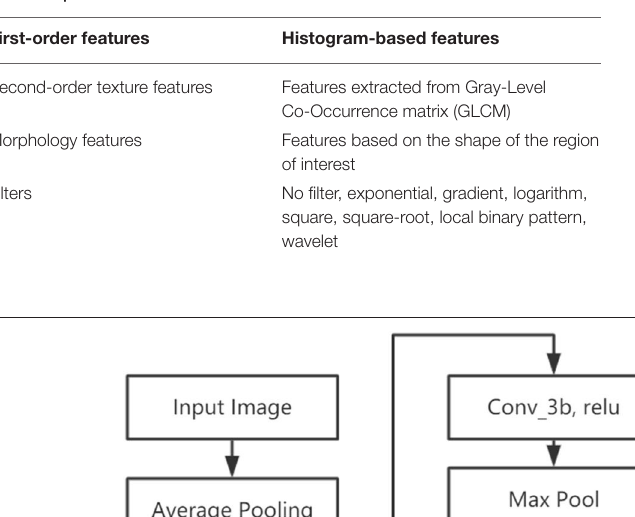
TABLE 1 | List of radiomic feature classes and filters.